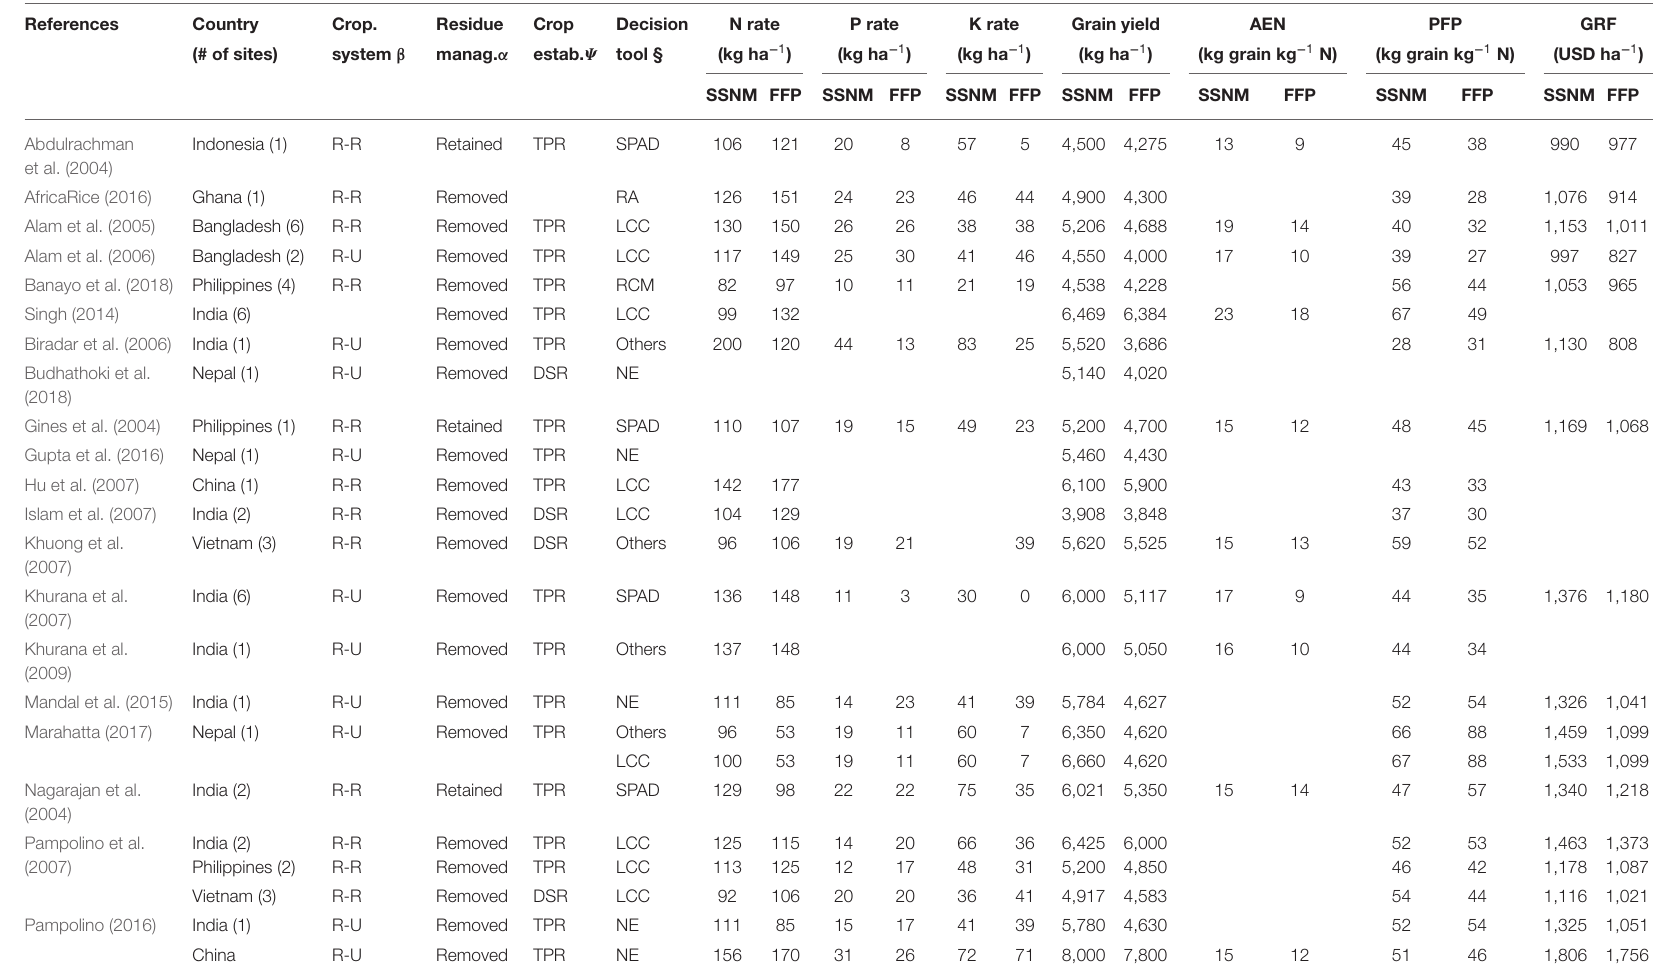
TABLE 1 | A synthesis of studies conducted in rice cropping systems on different sites in different countries in Asia and Africa under different agronomic management practices that evaluated the site-specific nutrient management (SSNM) compared to the farmer fertilizer practice (FFP) in terms of grain yield, agronomic efficiency of N (AEN), partial factor productivity of N (PFP N), and gross return above fertilizer cost